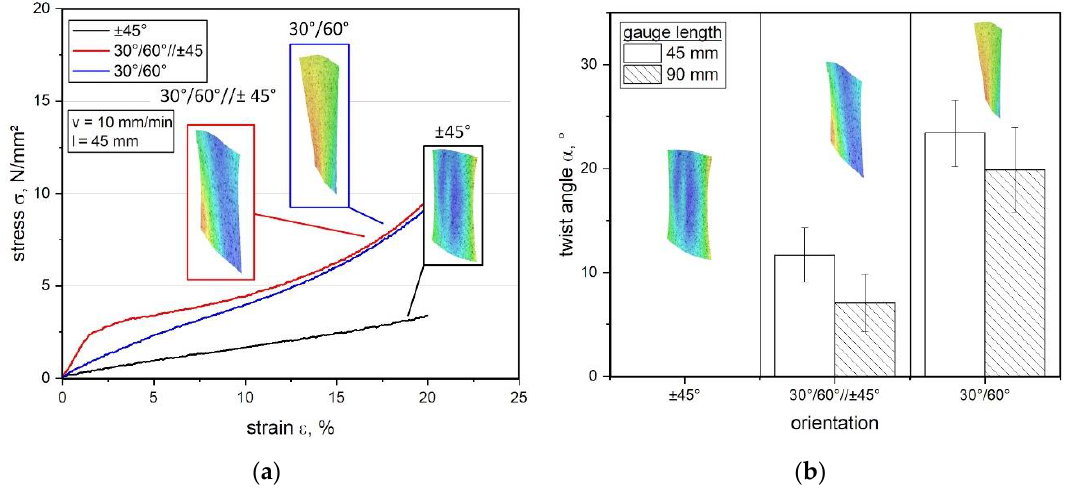
Figure 5. Stress-strain curves obtained from tension-twist load-coupling tests for GF-PDMS composites with textile reinforcement ( a ) and comparison of different gauge lengths versus inherent stiffness on the twist angle α performed with different fiber orientations ( b ) including digital image correlation in false color display.